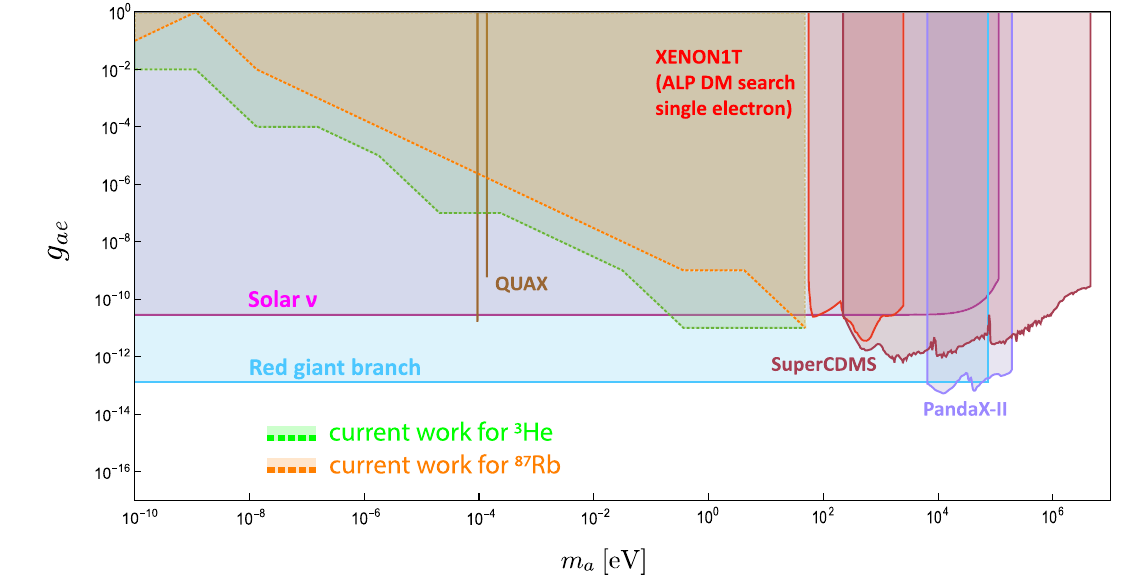
Fig. 3 The exclusion areas in the plane of ALP mass and the coupling constant of ALP–electron interaction for 3 He and 87 Rb compared with other proposals